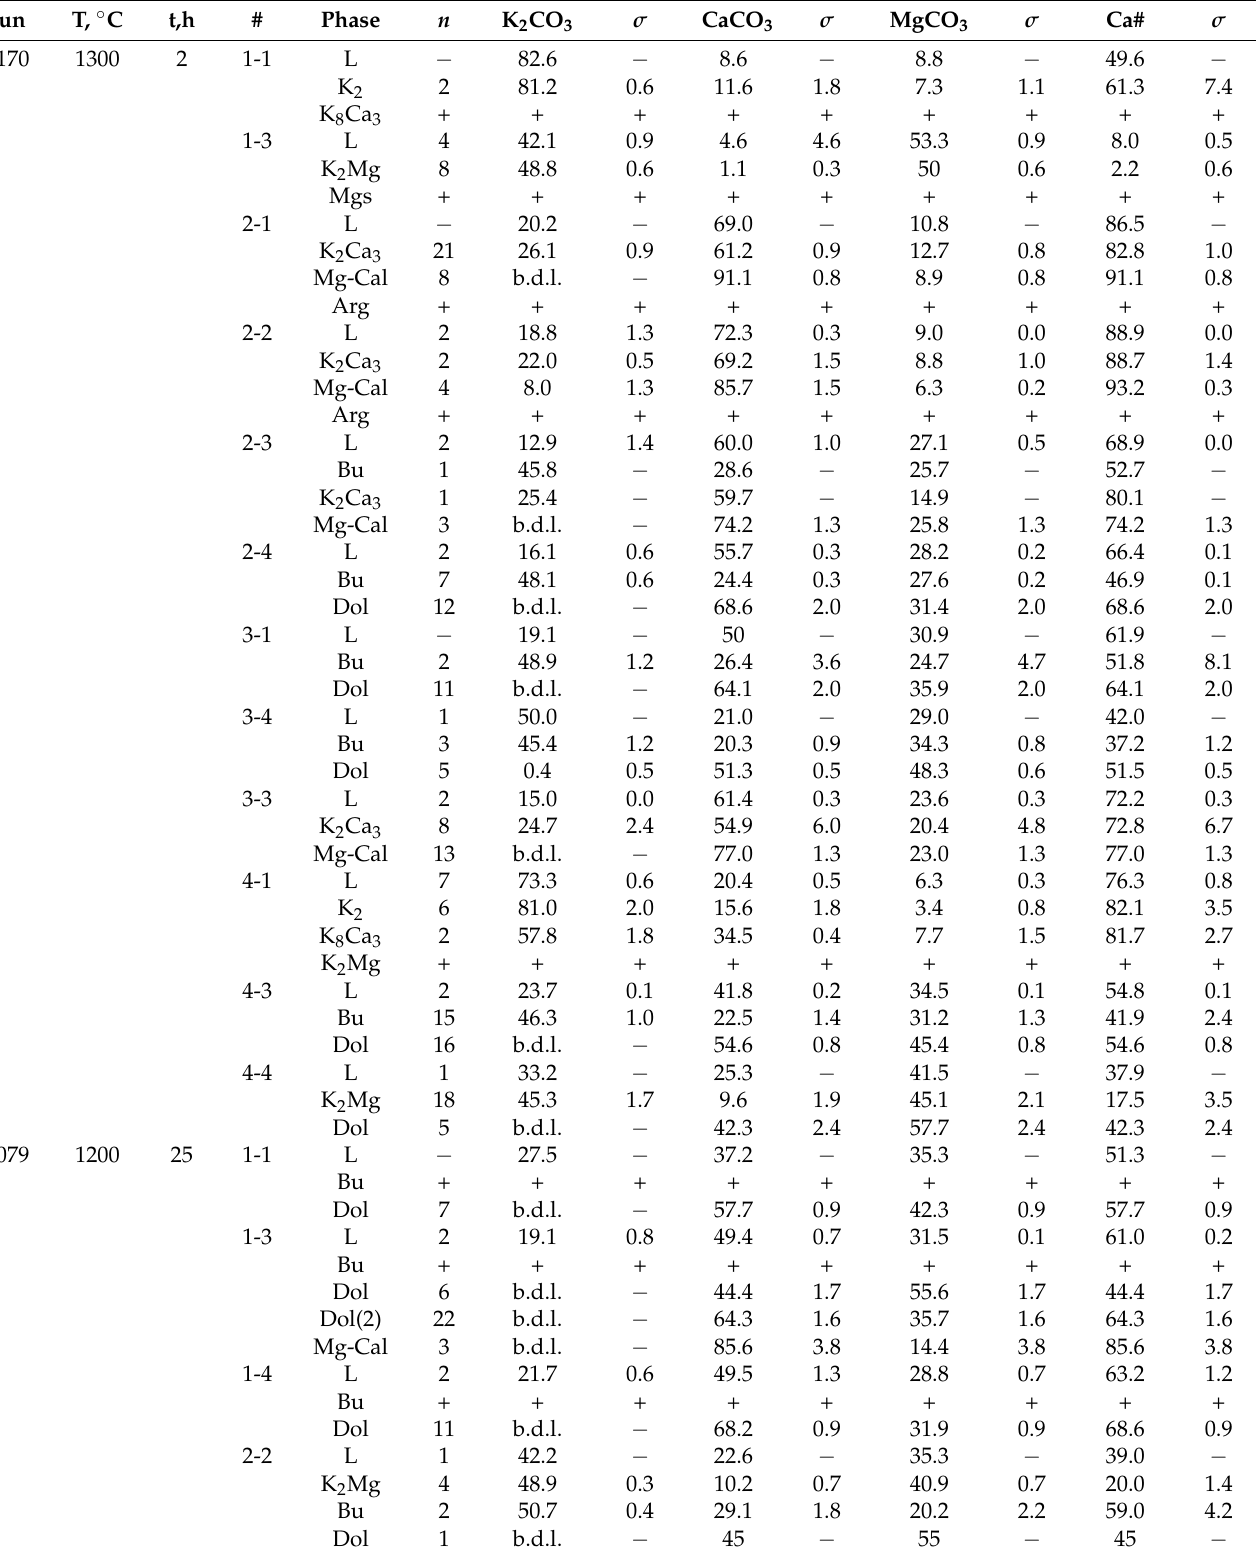
Table 1. Composition of quench products of K 2 CO 3 –CaCO 3 –MgCO 3 melt at 6